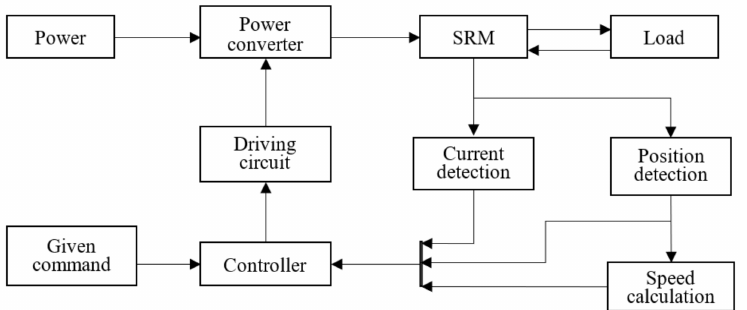
Figure 4. SRD system block